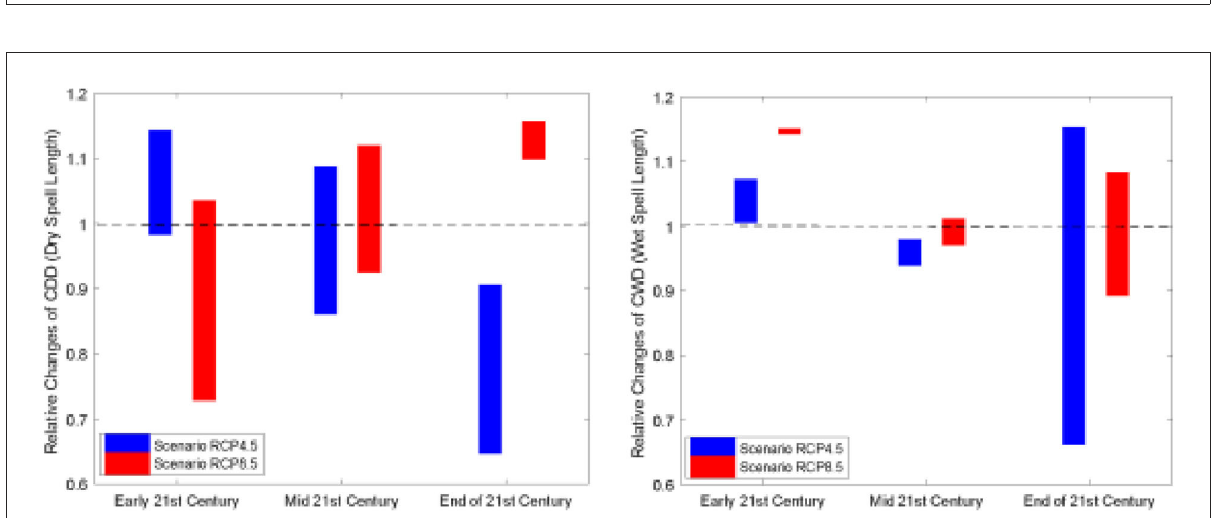
FIGURE5 Relative changes of dry spells (left panel) and wet spells (right panel) for the early 21st century (2011–2040), mid-21st century (2041–2070) and end of 21st century (2071–2100) for both RCP4.5 and RCP8.5 downscaled projection at Subang. The dotted line indicates no changes between the future and the historical